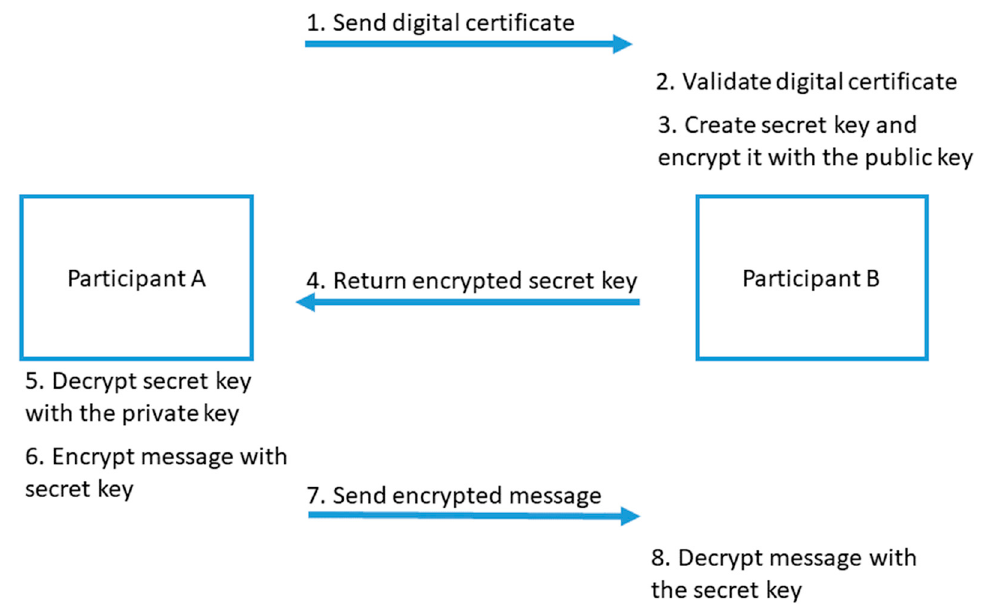
Figure 4. Set-up of encrypted communication used in the Encrypted Channels pattern.